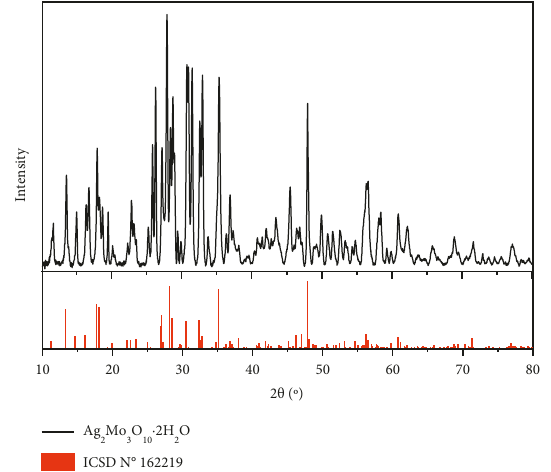
Figure 2: X-ray diffraction pattern of the Ag nanorods obtained by the hydrothermal method.